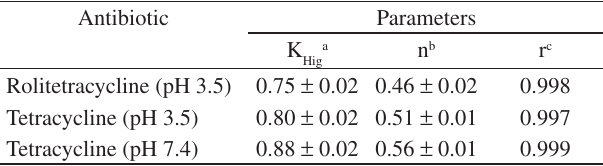
Tabela 2. Kinetics parameters a the release of tetacycline and rolitetracycline dispersed in anionic collagen membranes at 37 °C Antibiotic